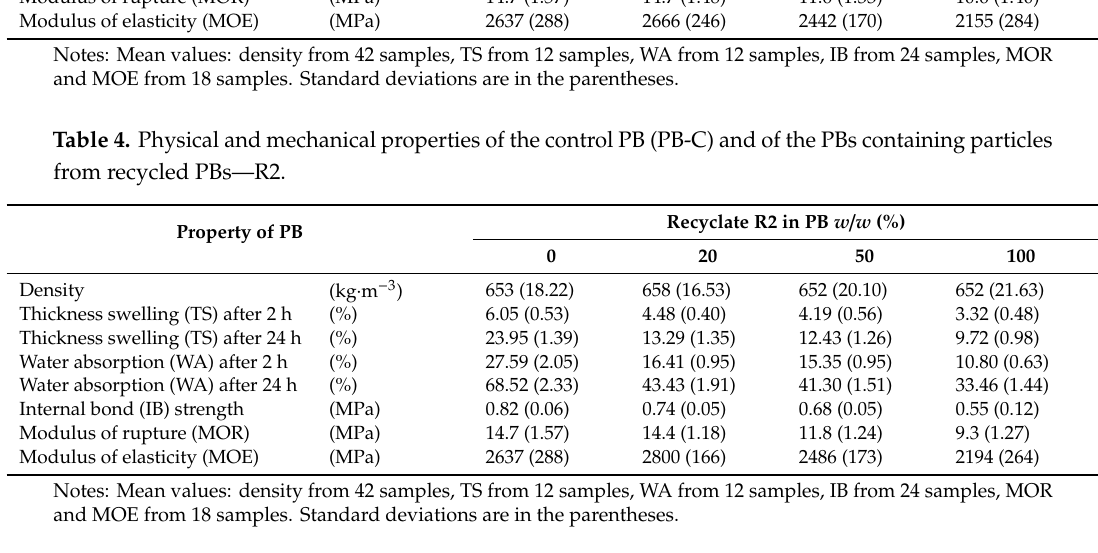
Table 3. Physical and mechanical properties of the control PB (PB-C) and of the PBs containing particles from a mixture of wood recycled products—R1.